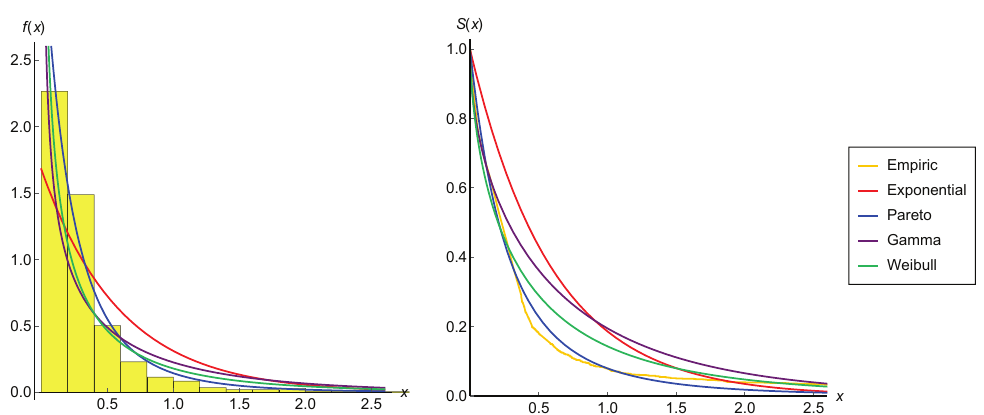
Figure 8. The goodness-of-fit of several parametric distributions to the empirical distribution of the claim data.